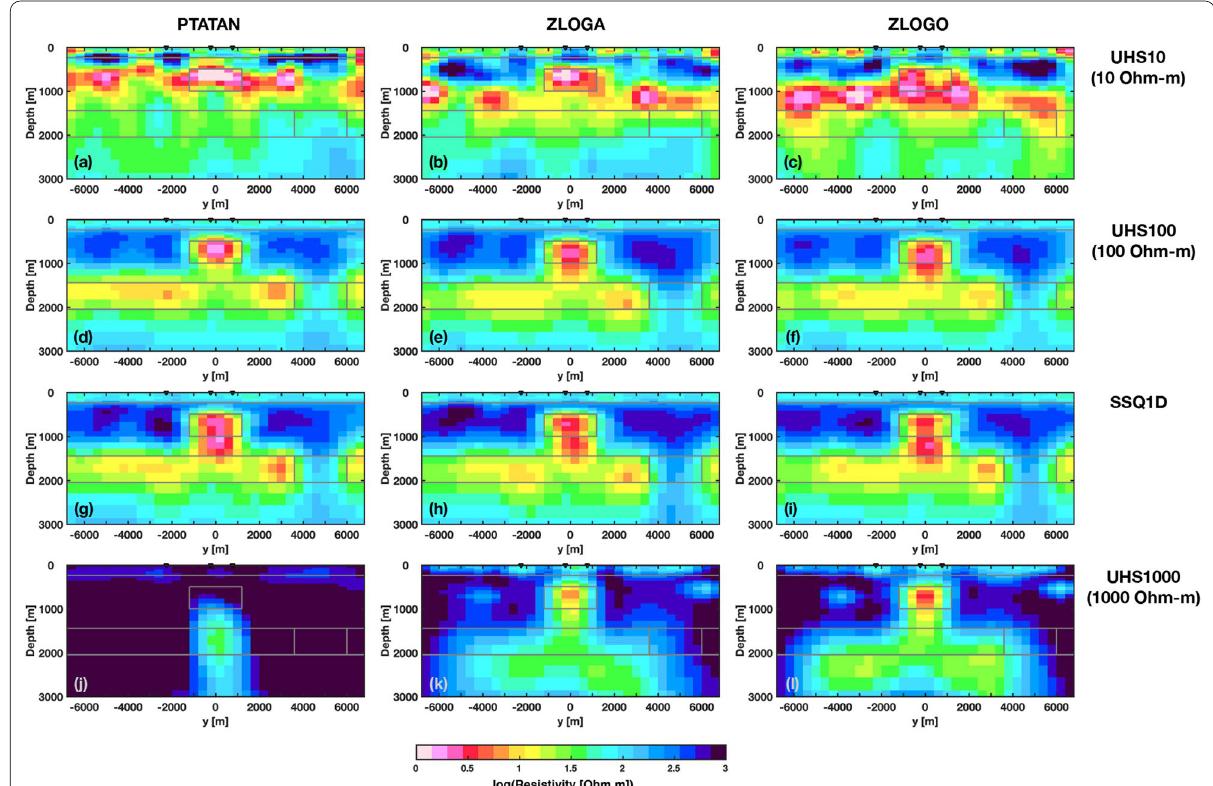
Fig. 8 North–south (NS) cross sections at the easting of 200 m of the models inverted from the undistorted data using ( a , d , g , j ) PTATAN, ( b , e , h , k ) ZLOGA, and ( c , f , i , l ) ZLOGO with different initial models. The geometry of anomalies in the input model (Fig. 1) is represented by the gray solid line